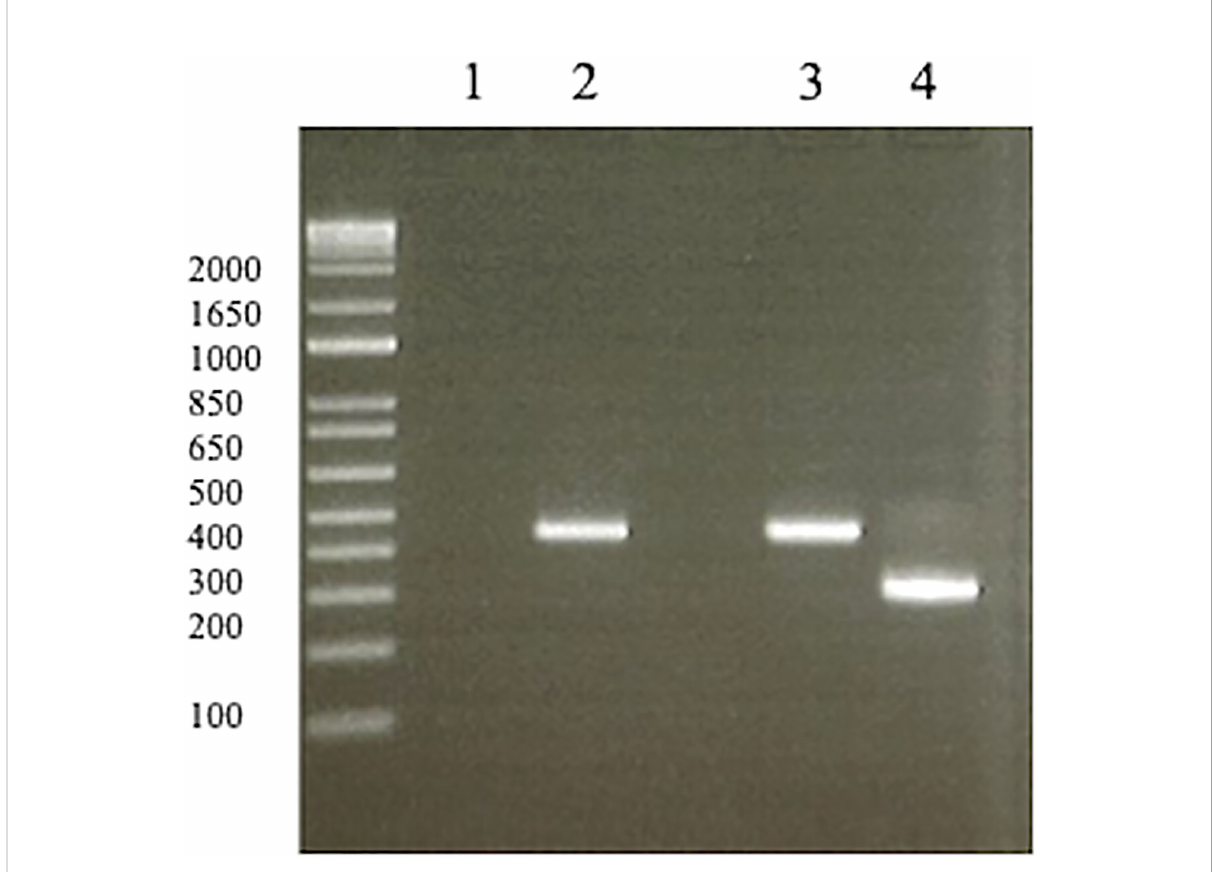
FIGURE 1 Reverse transcription PCR of negative/positive controls (1, 3, 4) and biopsy specimen before osimertinib administration from the patient (2). (1) No template (negative control). (2) The biopsy specimen before osimertinib administration was negative for MET ex14del. (3) MET ex14del wild type sample (negative control). (4) MET ex14del positive sample (positive control). MET , mesenchymal-epithelial transition